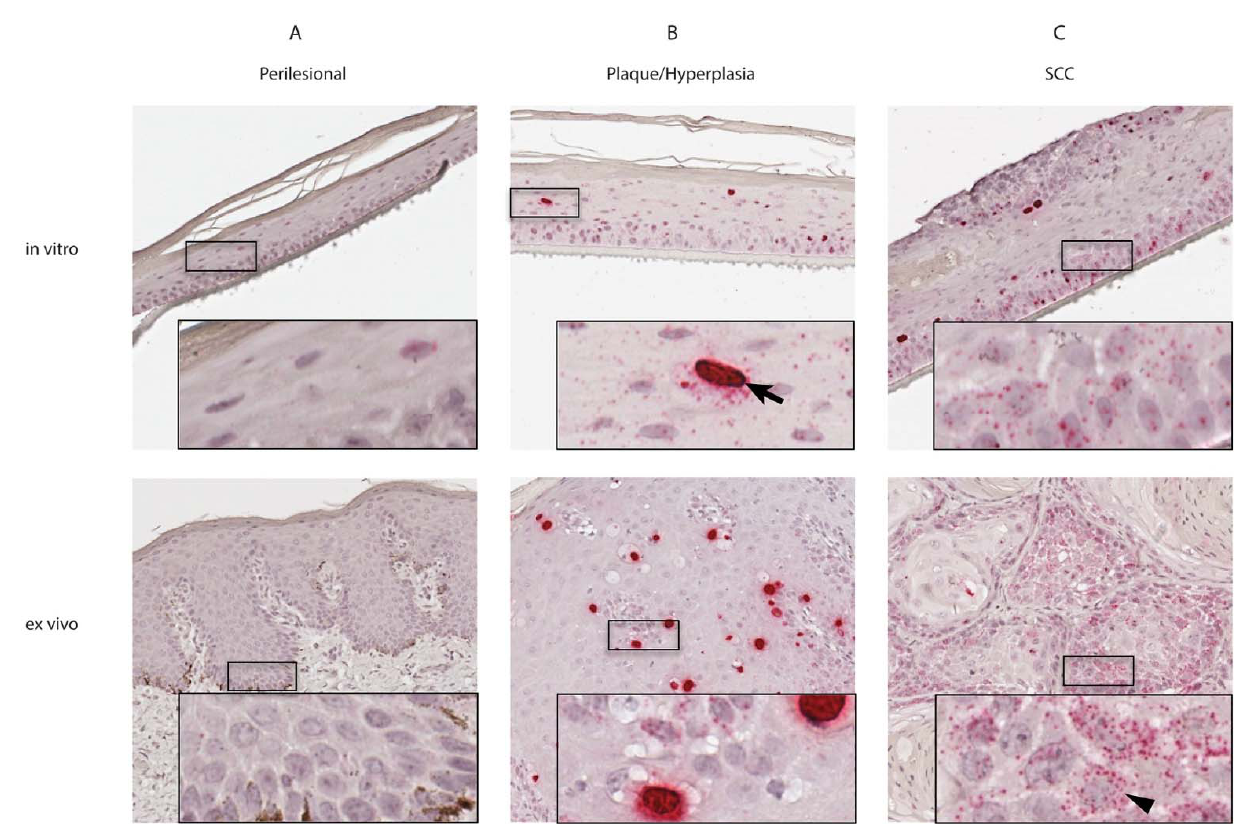
Figure 2. Equine papillomavirus type 2 (EcPV2) signal distribution patterns in raft cultures and corresponding tissue sections using RNA in situ hybridization (RISH). EcPV2 RISH of representative areas of perilesional ( A ), plaque/hyperplasia ( B ) and squamous cell carcinoma (SCC) ( C ) raft cultures and tissue sections. ( A ) Perilesional skin-derived rafts and tissue sections contain just a few cells with weak granular signal (GS). ( B ) In plaque-derived rafts and tissue sections, moderate GS and scattered diffuse nuclear signal (DNS) (arrow) is present. ( C ) In SCC-derived rafts and tissue sections, strong GS (arrowhead) is present, while rafts also display rare DNS. All photographs taken using 10× objective.